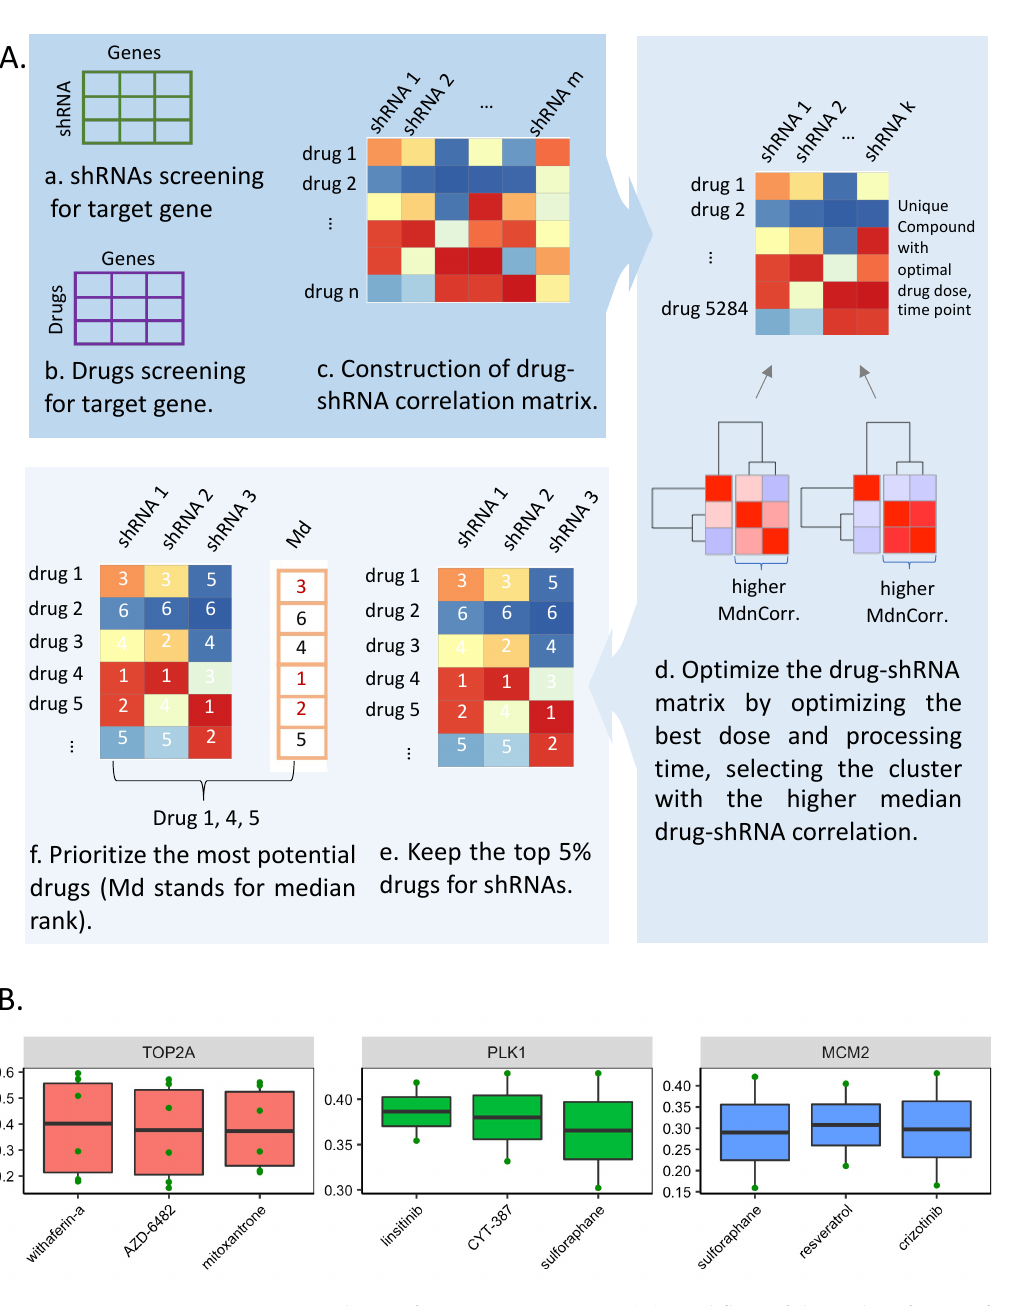
Figure 5. Drug prediction for HCC target genes. ( A ) Workflow of drug identification for target genes. The MdnCorr here stands for the median correlation coefficient. ( B ) The box plot showed top three effective drugs for each target gene. Each point in the box plot represents a shRNA for knockdown of corresponding target